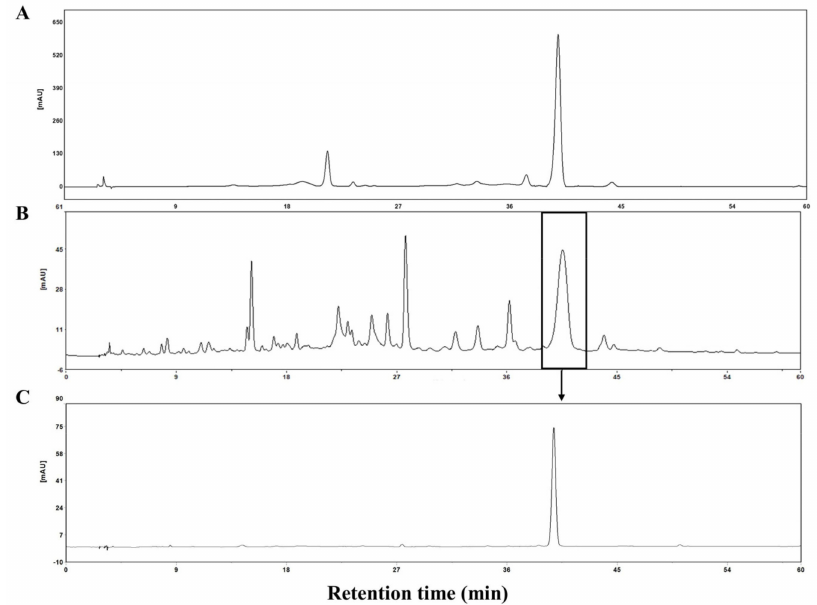
Figure A1. HPLC spectrum of Lycium ruthenicum Murr. ( LR) and p3cr5g. The eluted gradient: 0–20 min, 10–17% A; 20–25 min, 17% A; 25–55 min, 17–25%; 55–60 min, 25–90% A. Mobile